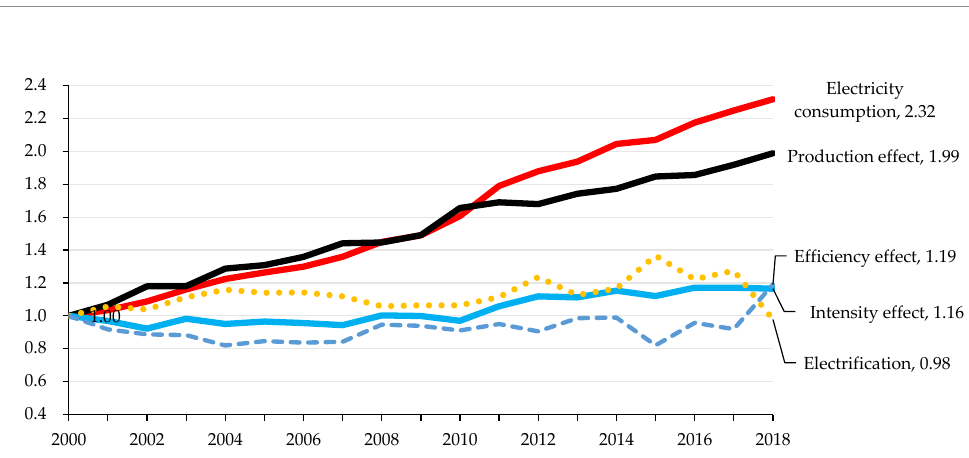
Figure A4. Petrochemical electricity consumption LMDI results (fixed base year, multiplicative).